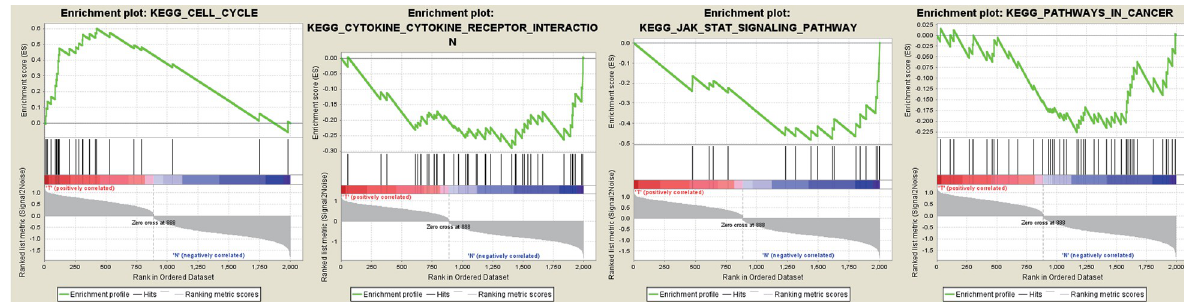
Fig 5. Enrichment plots for the four gene sets (pathways) that were strongly related to breast cancer.